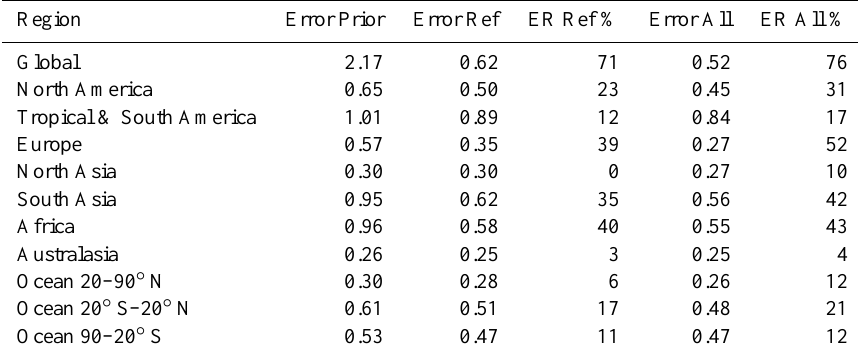
Table 5. Prior and posterior error (Tga − 1 N) and error reduction (ER) calculated from Monte Carlo ensembles for the reference data set (Ref) and all data